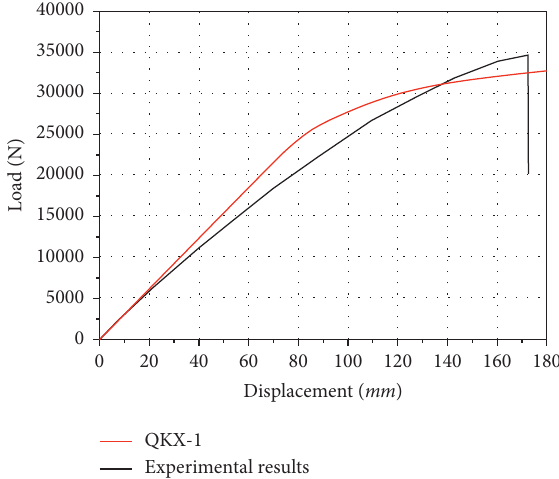
Figure 15: Comparison of load-displacement curve for QKX-1. Table 2: Comparison of the ultimate bearing capacity and initial stiffness for QKX-1.